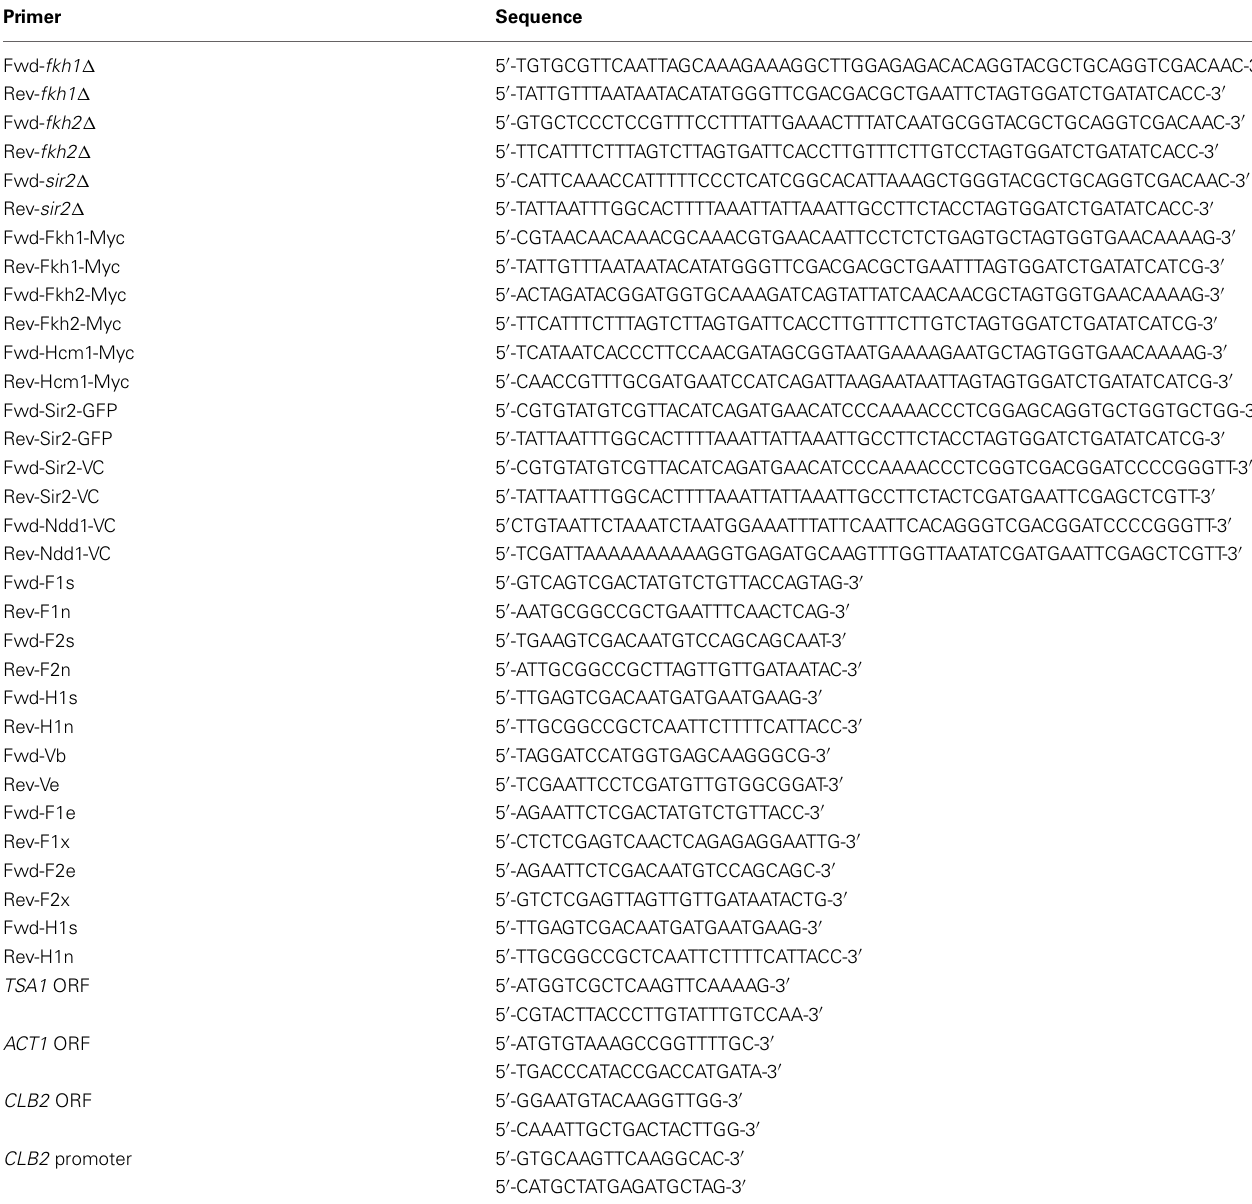
Table 2 | Oligonucleotides used in this study. Primer